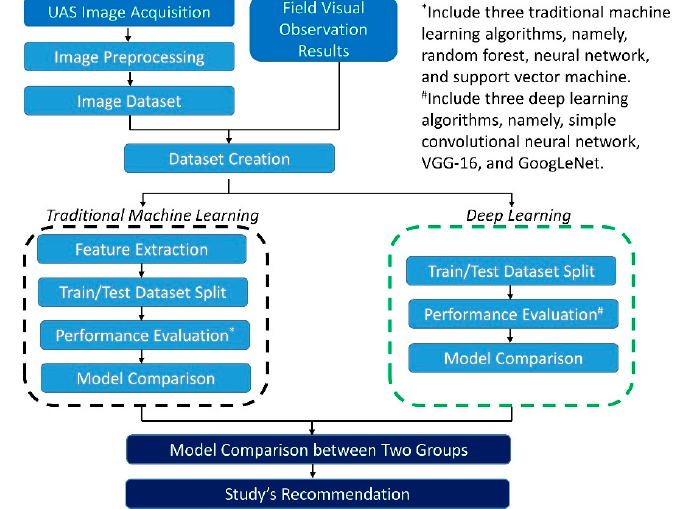
Figure 1. Overall process flowchart of lodging detection using traditional machine learning and deep learning with visual field observation results.